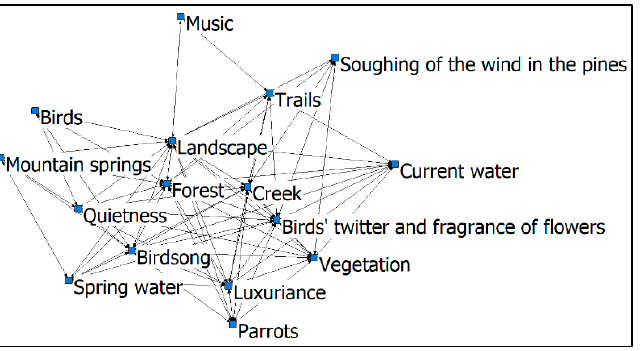
Figure 10. 2-1. Urban forest park elements based on audio-visual interactive perception. Figure 11. 3-1. Natural scenery based on visual and tactile interactive perception. In terms of multi-sensory interactive experience, although the visual experience dom- inates, the sense of hearing is necessary for people to obtain information and fully perceive their surroundings [14–16]. A bulk of academic research has been conducted from the perspective of audio-visual interaction [57]. Cluster 2-1 is a group of words relating to the soundscape, such as ‘Soughing of the wind in the pines’, ‘Birdsong’, ‘Music’, and other soundscape sources such as ‘Stream’, ‘Current water’, ‘Mountain spring’ and ‘Parrot’. It